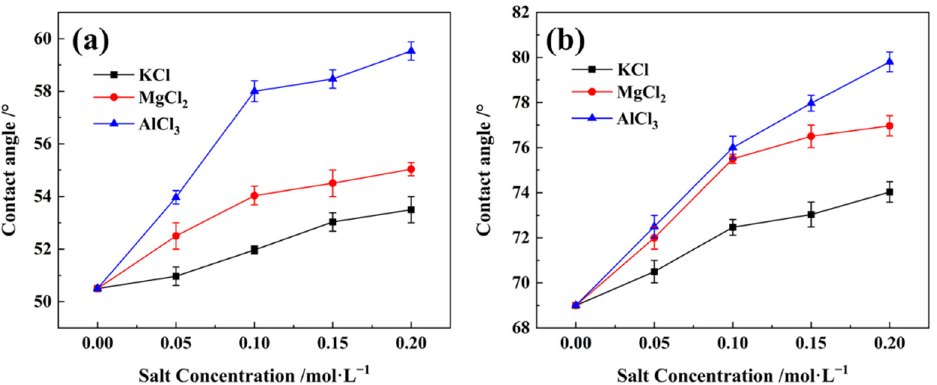
Figure 4. Contact angle of graphite as a function of inorganic salt concentration in the ( a ) absence and ( b ) presence of collectors.